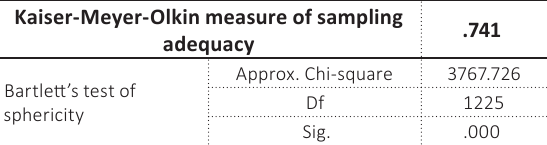
Table 5. KMO and Bartlett’s test